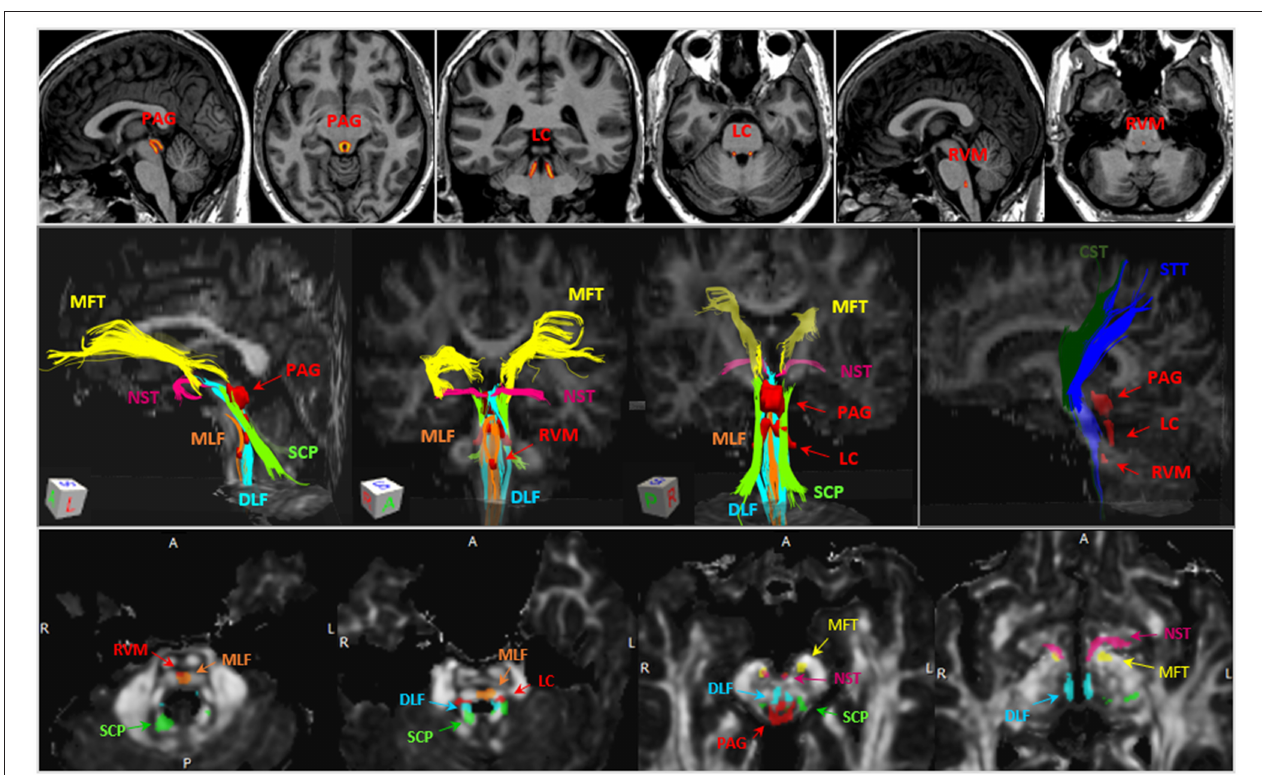
FIGURE 3 | Illustration of ROI where the volumes of the brainstem nuclei and diffusion metrics were measured. Upper panel , Illustration of ROIs of the PAG, LC and RVM, which were delineated based on literature ( 108). The hot color scale represents probability of gray matter density (brighter color refers to higher gray matter density) within the ROIs. Middle panel , example of brainstem tracts of interests, including MLF (orange), DLF (cyan), SCP (green), NST (dark pink), MFT (yellow), CST (dark green), STT (blue), and the three brainstem nuclei (red). Lower panel , the anatomical relationships between brainstem tracts (non-red) and nuclei (red) on 4 brainstem axial slices. PAG, periaqueductal gray; LC, locus coeruleus; RVM, rostral ventromedial medulla; MLF, medial longitudinal fasciculus; DLF, dorsal longitudinal fasciculus; SCP, superior cerebellar peduncle; NST, nigrostriatal tract; MFT, medial forebrain tract; CST, corticospinal tract; STT, spinothalamic